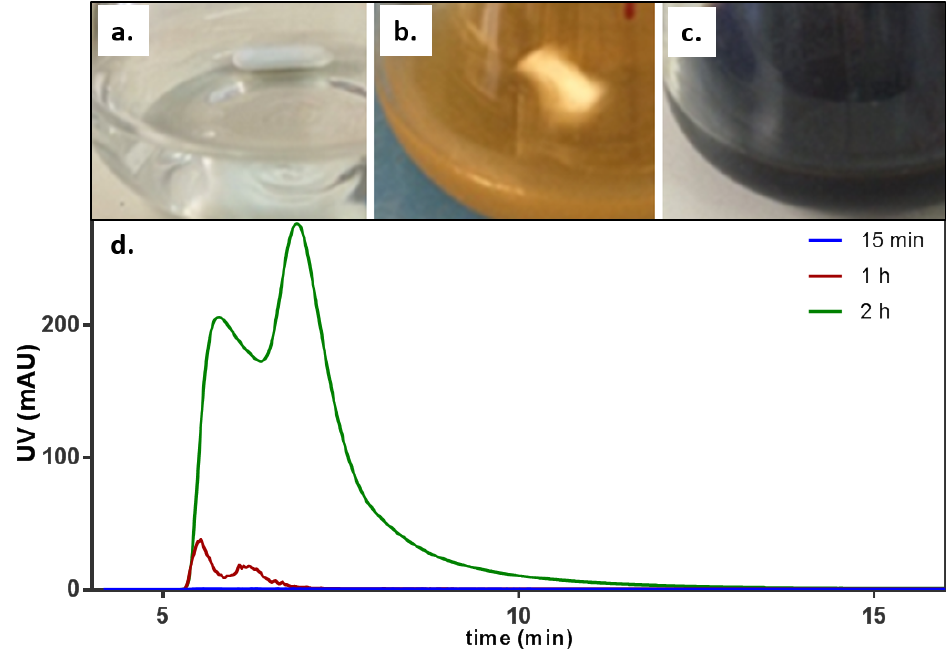
Figure 1. Appearance of the mixed solution over time after ( a ) 15 min, ( b ) 1 h, and ( c ) 2 h. ( d ) Absorption signal corresponding to the first stages of Ag-PDA formation, monitored by sampling and injection into FFF multidetection after 15 min (blue), 1 h (red), and 2 h (green). Following this, the reaction was monitored until (i) a peak was visible and intense and (ii) the peak was also detectable from the MALS analysis, which occurred after a reaction time of about 20 h, which was consistent with the literature [54–56]. After this, the